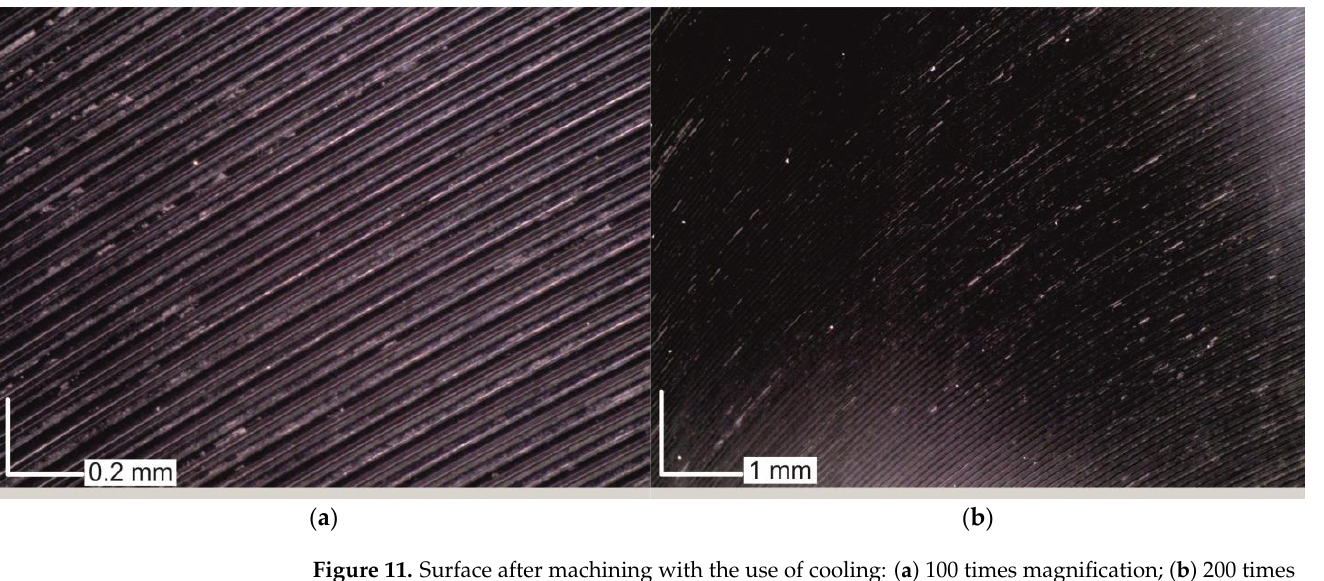
Figure 11. Surface after machining with the use of cooling: ( a ) 100 times magnification; ( b ) 200 times magnification.